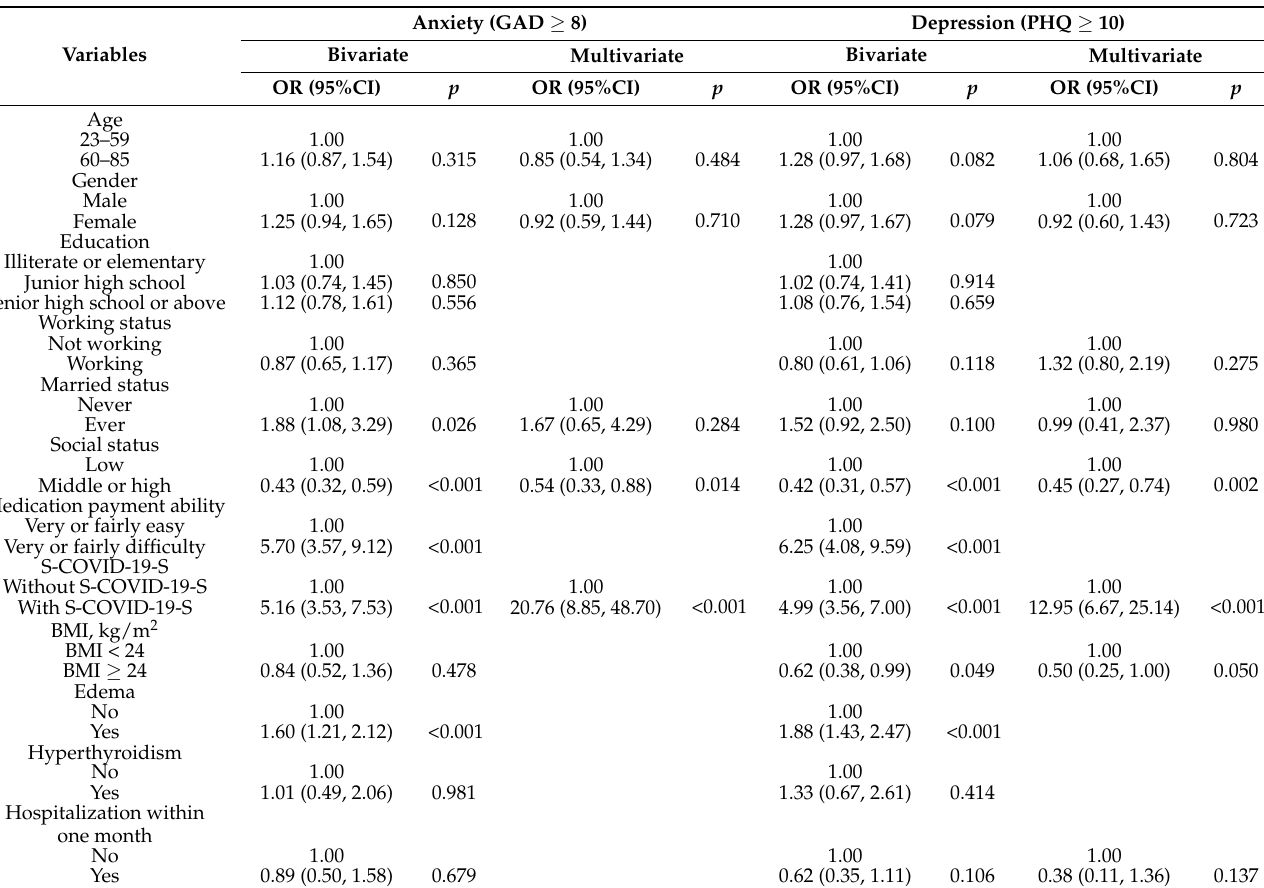
Table 3. Associated factors of anxiety and depression via bivariate and multivariate logistic regres- sion